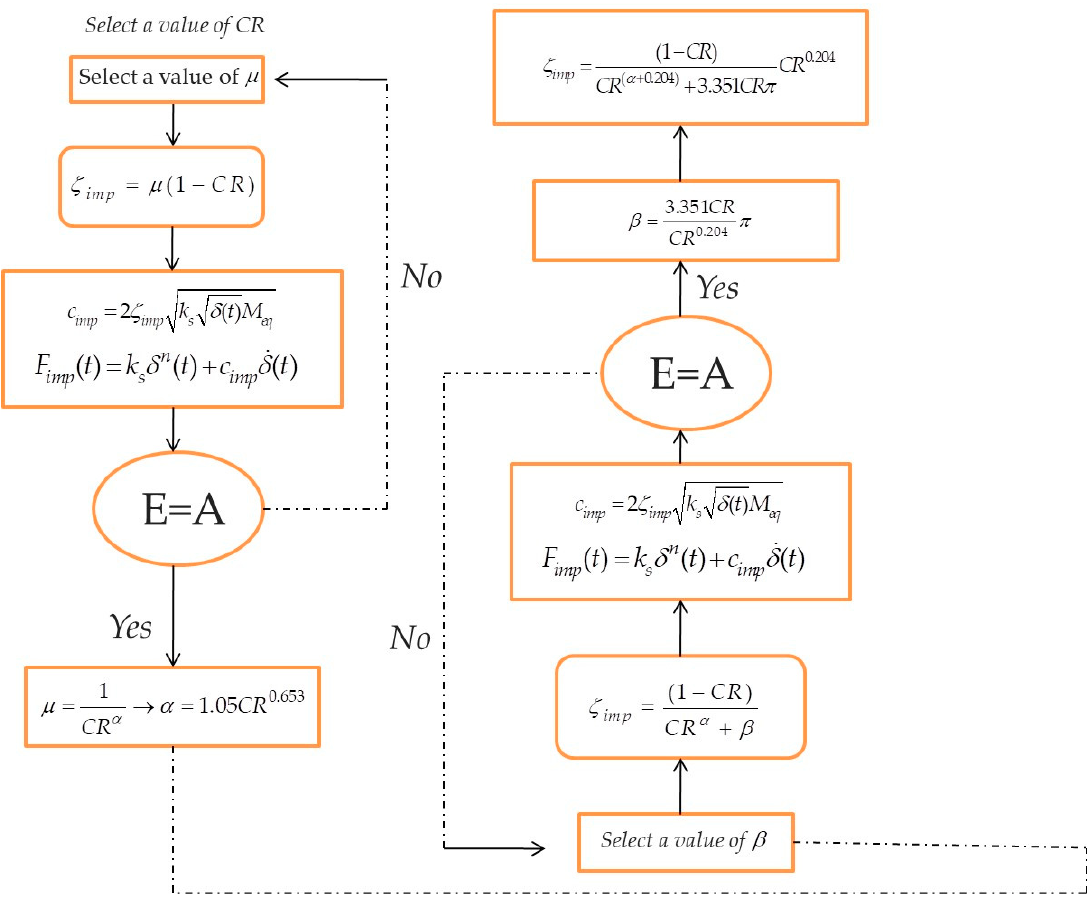
Figure 3. The detailed scheme of iterative procedure to determine the impact damping ratio.